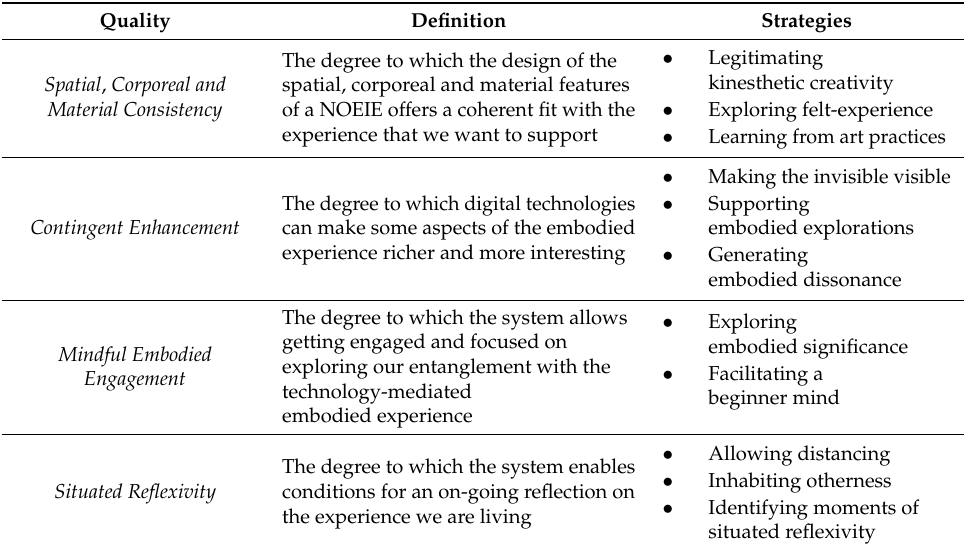
Table 1. Summary of the proposed qualities and